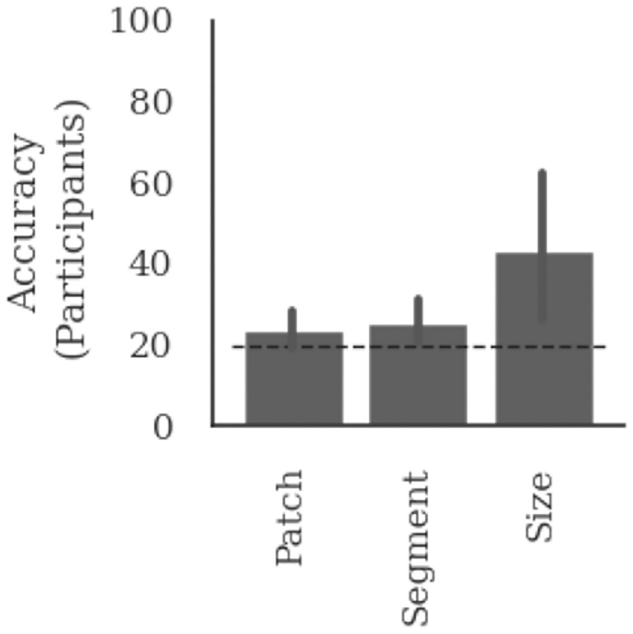
Fig 6. Results of telling participants the diagnostic cue. Each bar shows mean accuracy across 10 participants in the test block. Participants were divided into three groups based on the diagnostic cue—patch location, segment colour, or average size—used to train the